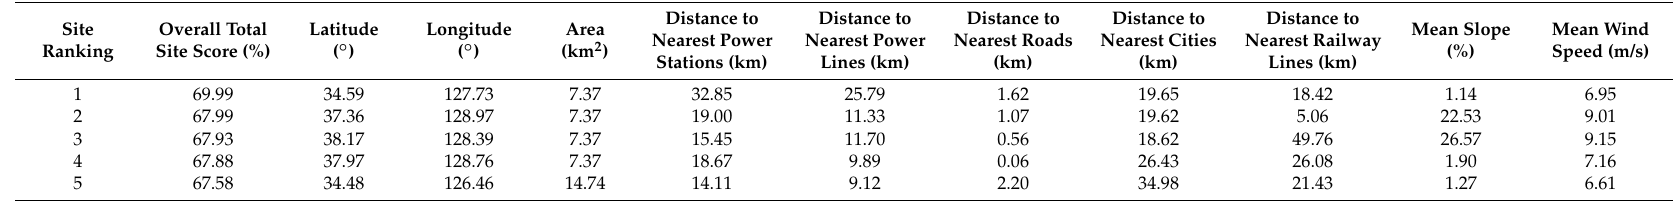
Table 18. Details of Top 5 wind farm sites in South Korea (Scenario